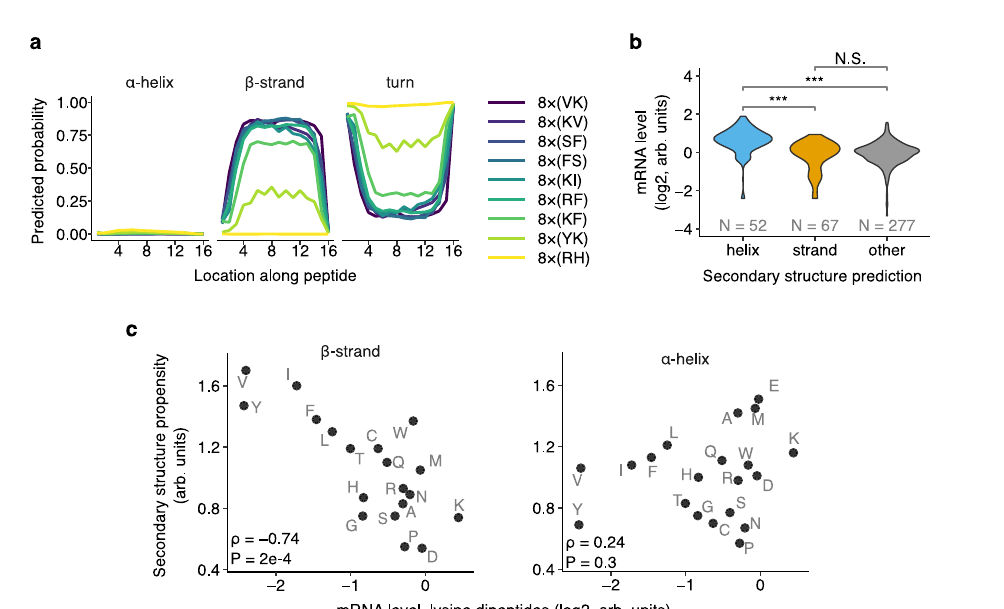
Fig. 3 | Secondary structure of dipeptide repeats mediates effects on mRNA levels. a Computationally predicted secondary structure probability along 16 amino acid-long peptide sequences encoded by destabilizing dipeptides. Second- ary structure probabilities are predicted using S4PRED 35 . b Distribution of mRNA levelsofdipeptiderepeat-encodingreportersfromFig.1cpartitionedbypredicted protein secondary structure. Per residue probability of secondary structure for- mation are predicted using S4PRED. Inserts with >50% average prediction prob- ability of forming α helix or β strand are classi fi ed as such, or else grouped as ‘ other ’ . N is the number of dipeptide repeats predicted in each